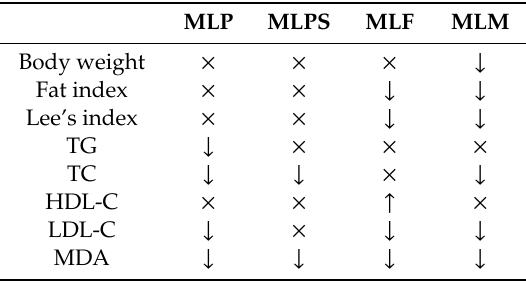
Table 3. The significant e ff ectiveness of di ff erent